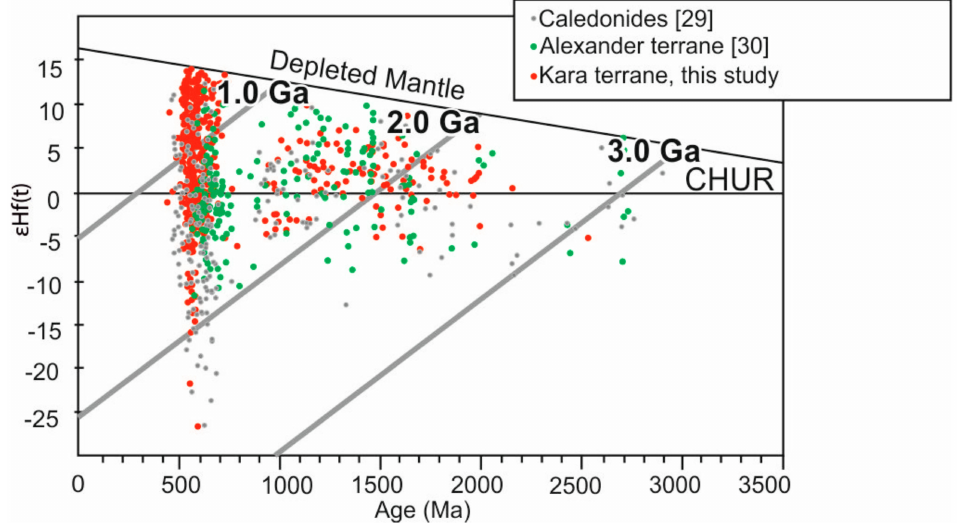
Figure 4. Initial ε Hf values plotted against age. Ages are given as 206 Pb / 238 U ages if equal to or younger than 1000 Ma; otherwise, 207 Pb / 206 Pb ages have been used (our data and data from